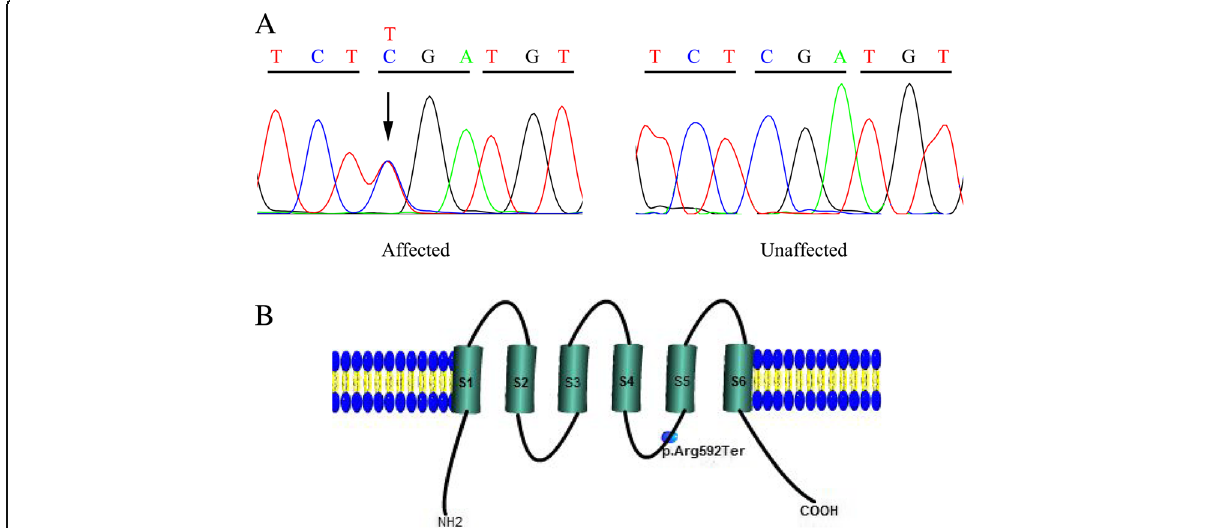
Fig.3 a The DNA sequencing chromatograms represent the affected and unaffected individuals. The corresponding DNA sequence is shown above the chromatograms and the arrow denotes the mutated nucleotide. b A graphic illustration of the 6 subunit transmembrane spanning PKD2 protein shows the position of identified mutation